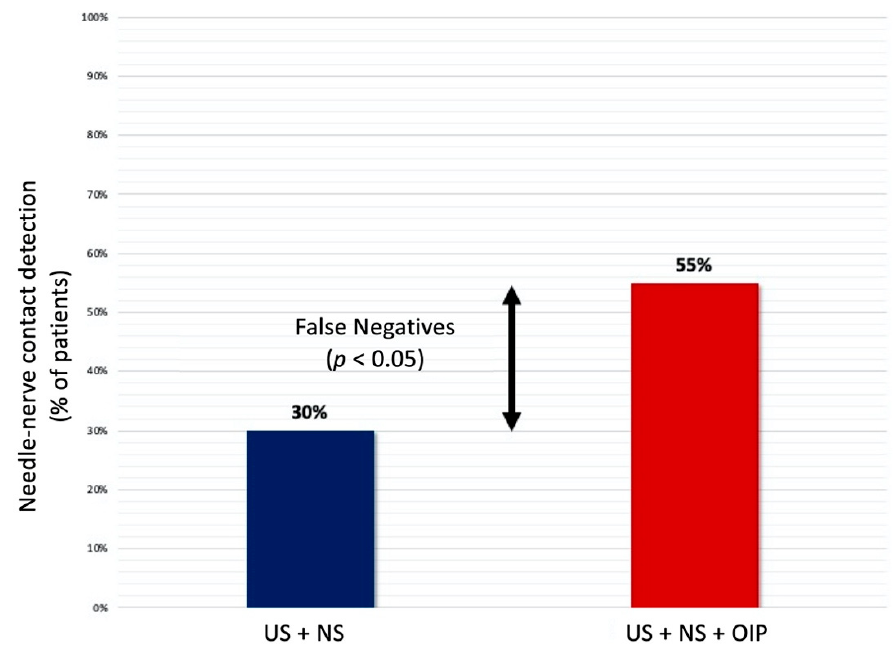
Figure 5. Needle–nerve contact detection.